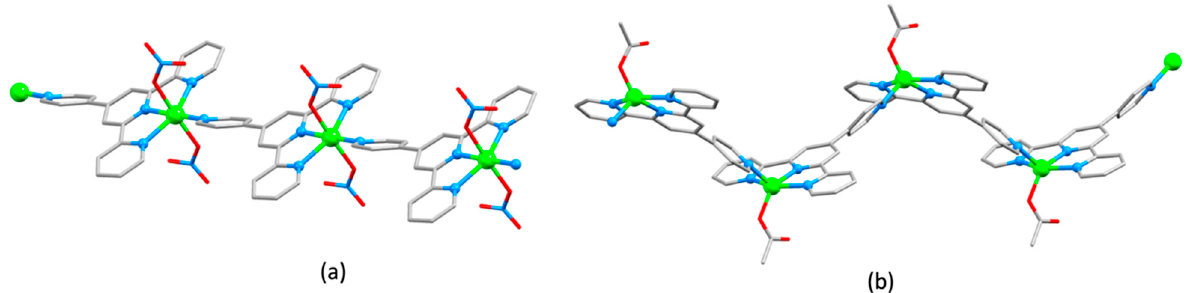
Figure 2. Parts of the 1D ‐ coordination polymer chains in (a) [Zn(4’ ‐ (4 ‐ py)tpy)(NO 3 ) 2 ] n (CSD refcode UPUFOB) and (b) [{Zn(4’ ‐ (4 ‐ py)tpy)(OAc)} n ] n + , isolated as the [PF 6 ] – salt (refcode WUJREA).